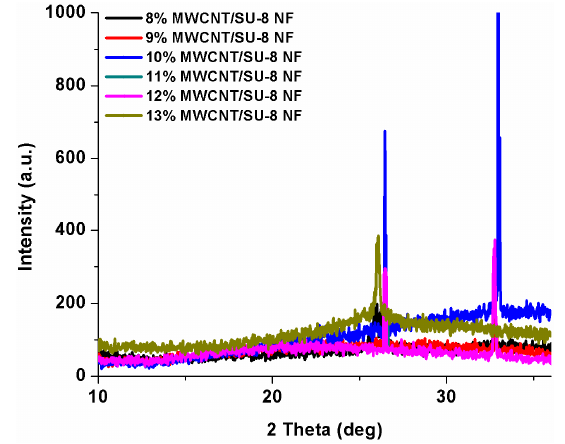
Figure 5. X-Ray Diffraction Analysis of MWCNTs/SU-8 nanofibers.